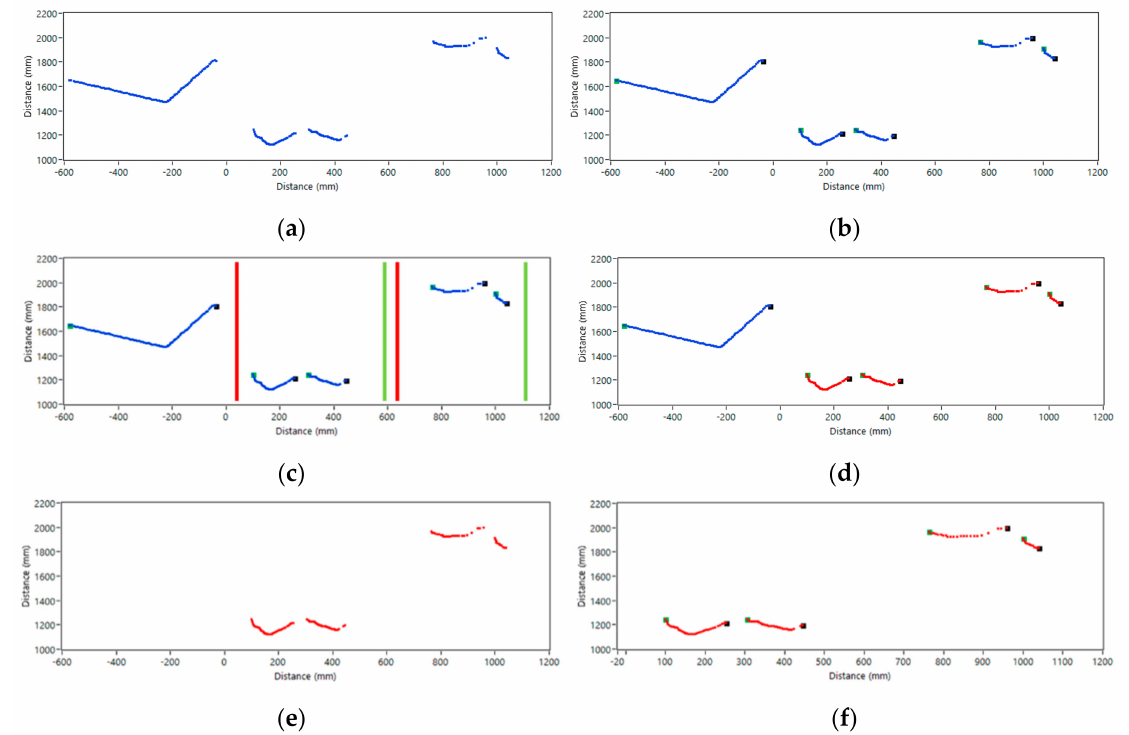
Figure 19. The processed laser scanner data: ( a ) raw, ( b ) after breakpoint generation, ( c ) fused with ROIs, ( d ) after classification, ( e ) removed obstacles, and ( f ) rescaled final result with breakpoints. Dots represent the beginning and end of the cluster, blue plots represent clustered laser data, red and green lines represent pedestrians’ poses, and red plots represent detected pedestrians in the laser